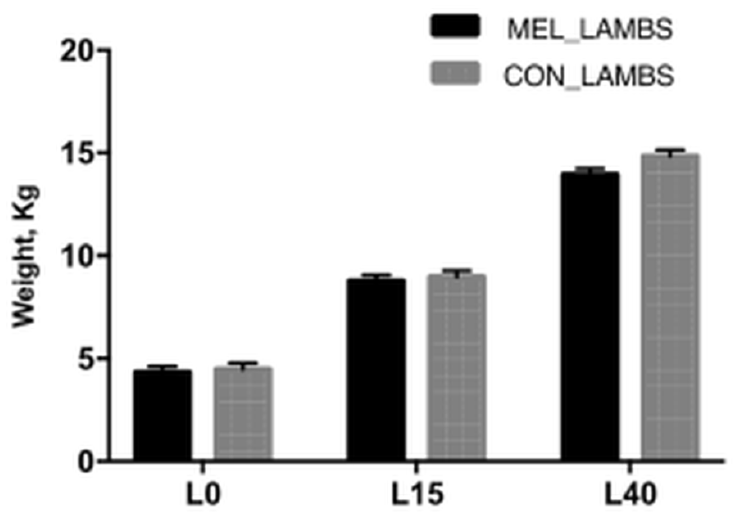
Figure 1. Least squares means ± SEM of body weight (Kg) of lambs, in control group (CON) and in melatonin group (MEL), at birth (L0) and on days 15 (L15) and 40 (L40) of their life, p > 0.05.